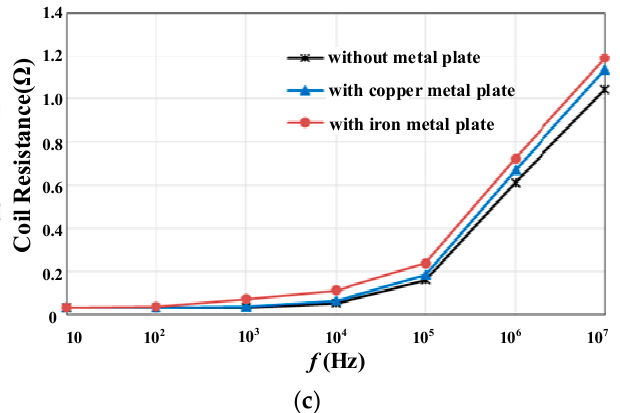
Figure 4. Helix coil parameters versus frequency with or without metal plate. ( a ) Inductance; ( b ) mutual inductance; ( c ) resistance.